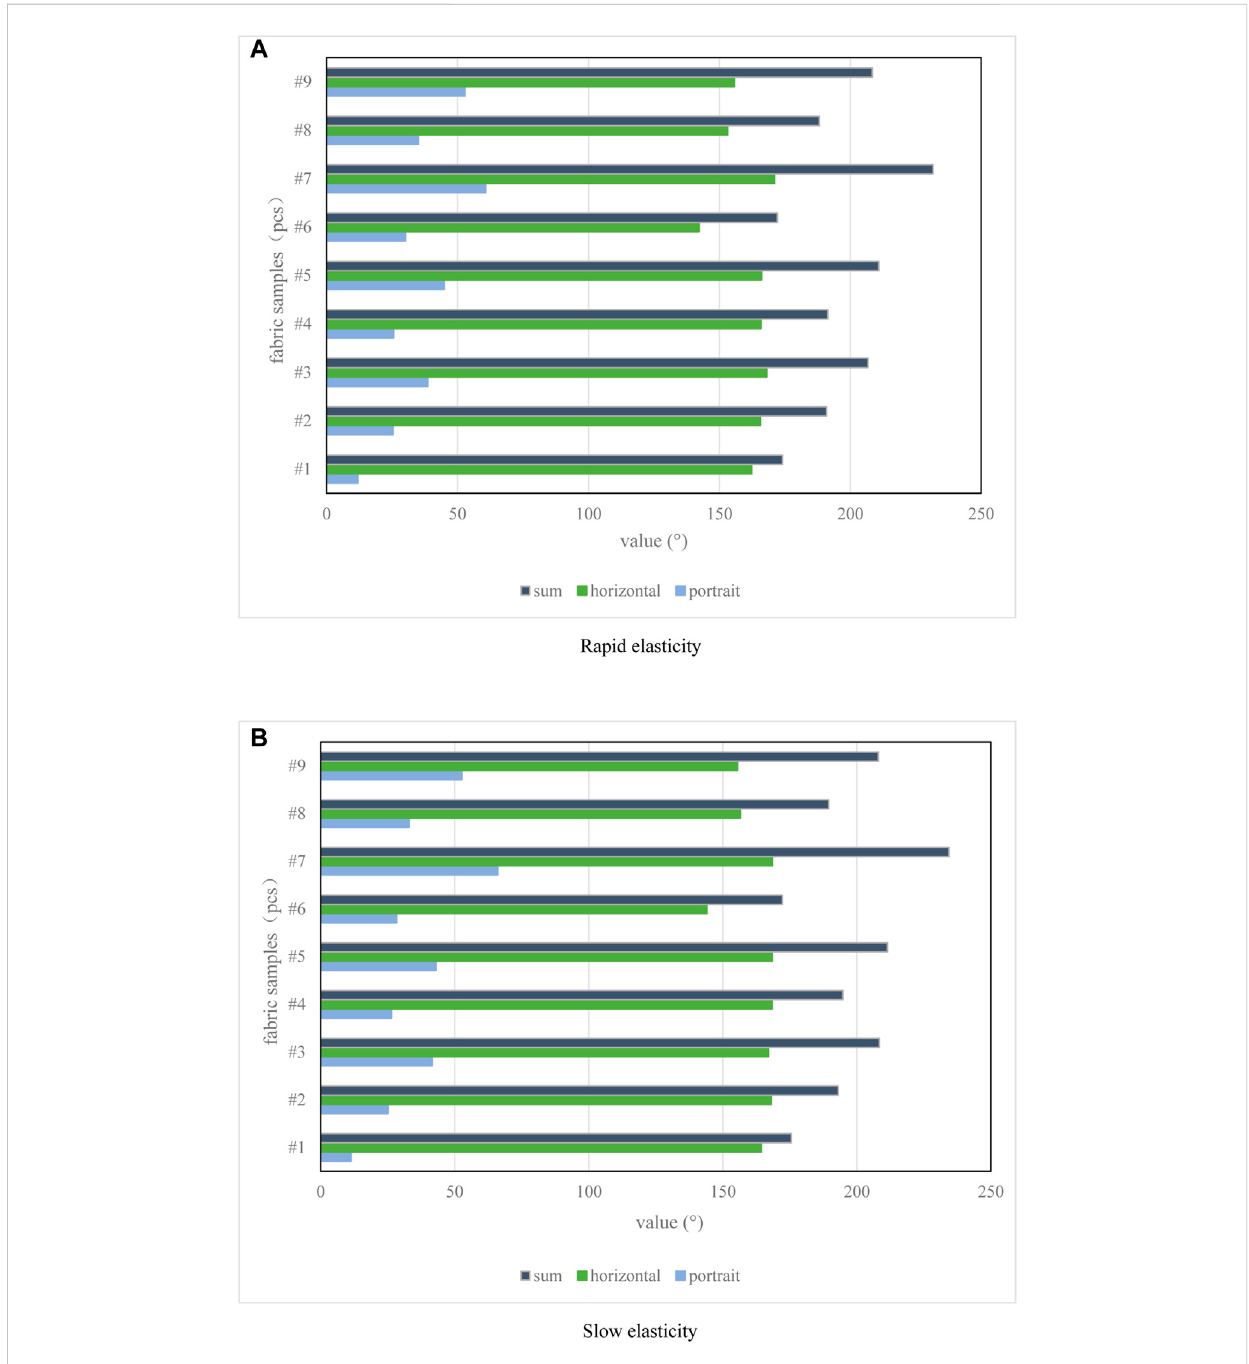
FIGURE 6 Test results of fabric wrinkle recovery. (A) . Rapid elasticity. (B) . Slow